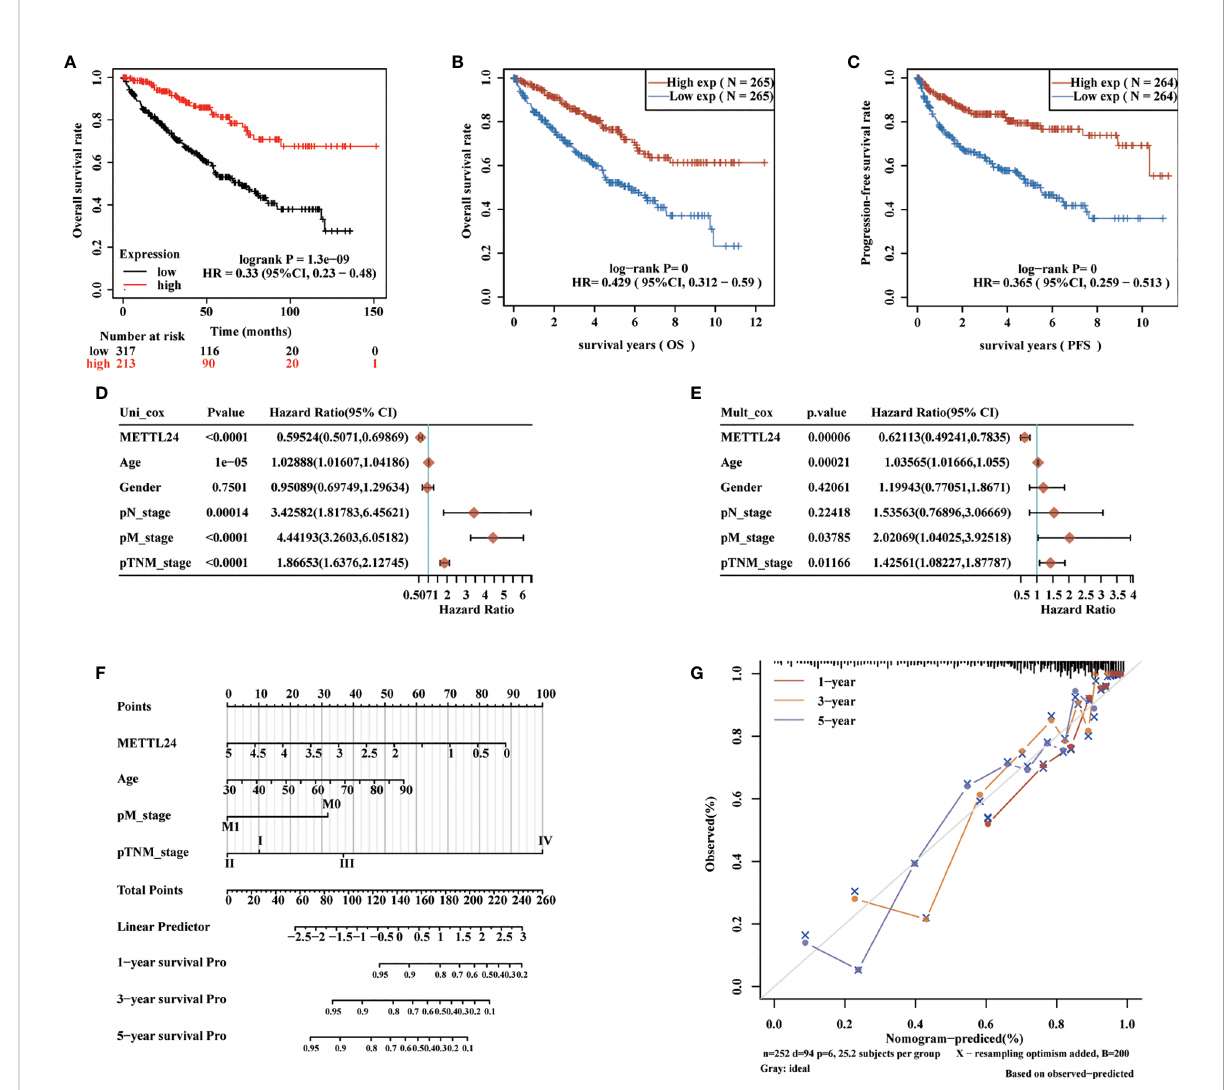
FIGURE 4 METTL24 as one potential prognostic gene for KIRC. (A, B) The Kaplan-Meier curve showed the impacts of METTL24 expression on the OS (C) and PFS of KIRC patients. (D) The forest image showed METTL24 as a potential risk factor for KIRC as analyzed using the univariate Cox regression. (E) The forest image showed METTL24 as one potential prognostic factor for KIRC as analyzed using the multivariate Cox regression. (F) A predictive nomogram based on the METTL24 risk score and other clinicopathological variables predicted the 1-, 3-, and 5-year survival rates of KIRC patients. (G) The Calibration curves indicated the agreement between anticipated and actual survival rates after 1, 3, and 5